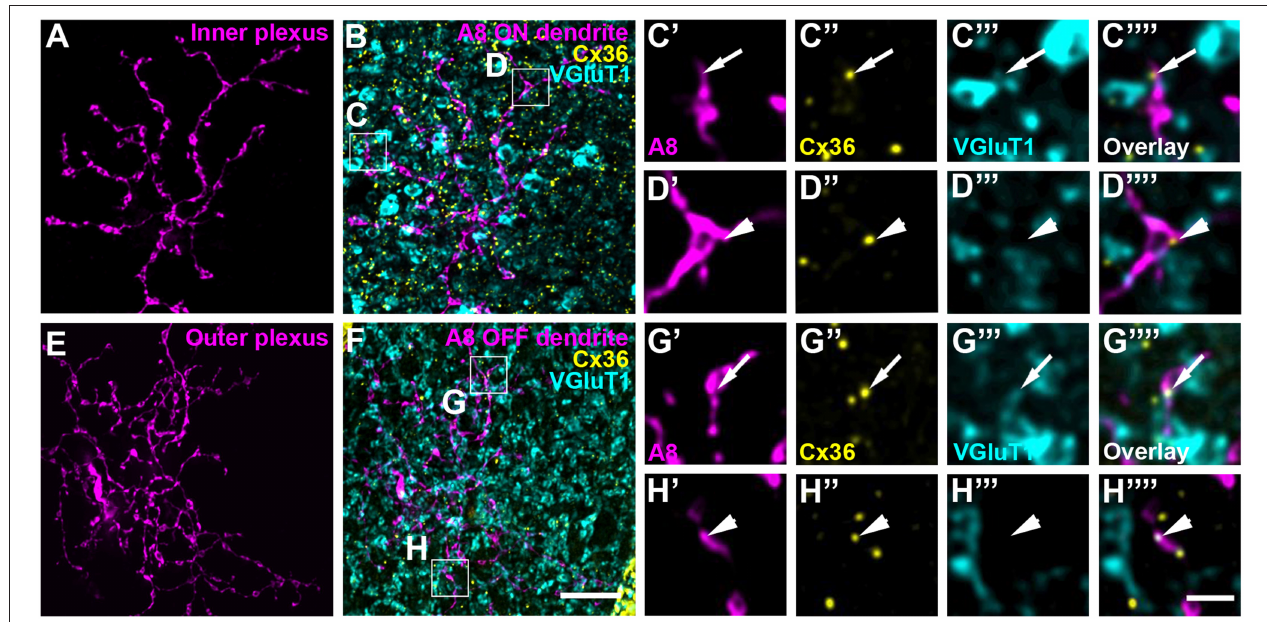
FIGURE 2 | A8 cell dendrites form Cx36-containing gap junctions with ON and OFF bipolar cell terminals. (A,E) Maximum projection of inner (A) and outer A8 dendrites (E) . (B,F) Maximum projections of the overlay of Cx36 and VGluT1 with inner (B) and outer dendrites (F) of an injected A8 cell. (C’–H”’) Selected areas from (B,F) as single, magnified sections: A8 dendrites (C’,D’,G’,H’) , Cx36 (C”,D”,G”,H”) , VGluT1 (C”’,D”’,G”’,H”’) and their respective overlay (C”’,D”’,G”’,H”’) within a single section from the selected ROI. Arrows denote colocalization of all three channels (C’–C””,G’–G””) . Arrowheads point to Cx36-positive puncta only colocalized with the injected A8 dendrite but not with VGluT1-positive bipolar cell terminals (D’–D””,H’–H””) . Scale bars: (A,B,E,F) , 10 µ m; (C’–D”’) , (G’–H””) , 2 µ m.